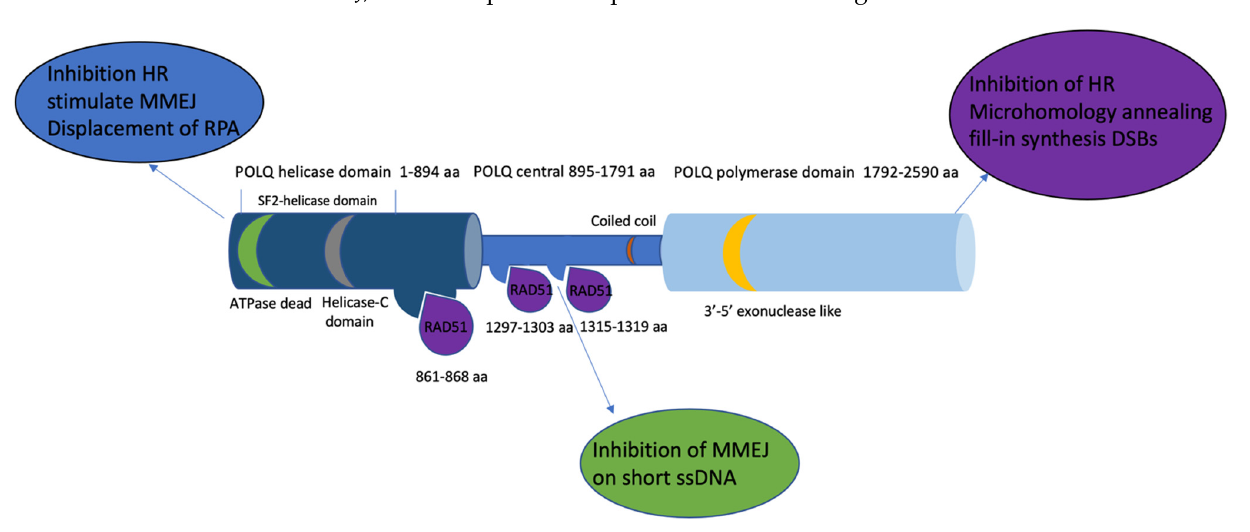
Figure 2. The POLQ protein includes a C-terminal domain containing a polymerase domain (1792–2590 aa, light blue), an N-terminal domain containing a helicase domain (1–894 aa, navy blue), and a central domain (895–1791 aa sky blue). The RAD51 (purple) binding site is located in both the helicase domain and central domain (861–868 aa, 1297–1303 aa, and 1315–1319 aa). The 3 ′ -5 ′ exonuclease-like region (yellow) is located on the polymerase domain. The superfamily 2 (SF2) helicase domain contains a conserved death box motif (green) and a conserved helicase C-terminal domain (grey). Text bubbles (blue, purple, and green) indicate the function of each domain of POLQ.